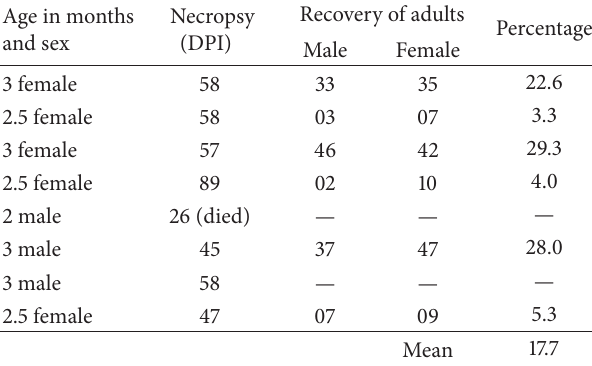
Table 4: Development of Toxocara canis in pups/dogs (mouse ). passage of L 2